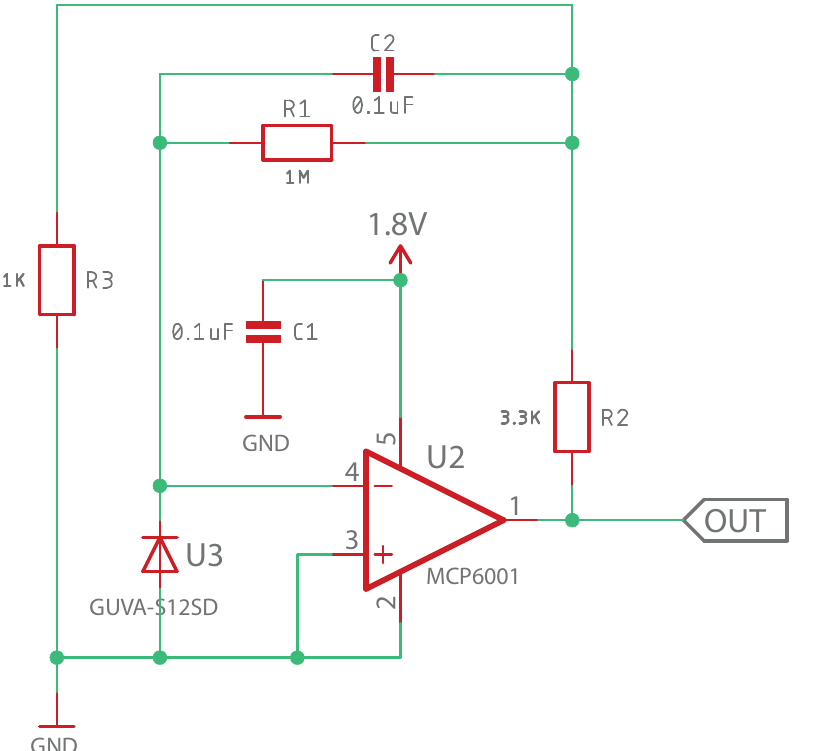
Figure 10. UV Sensor coupling stage schematic design.